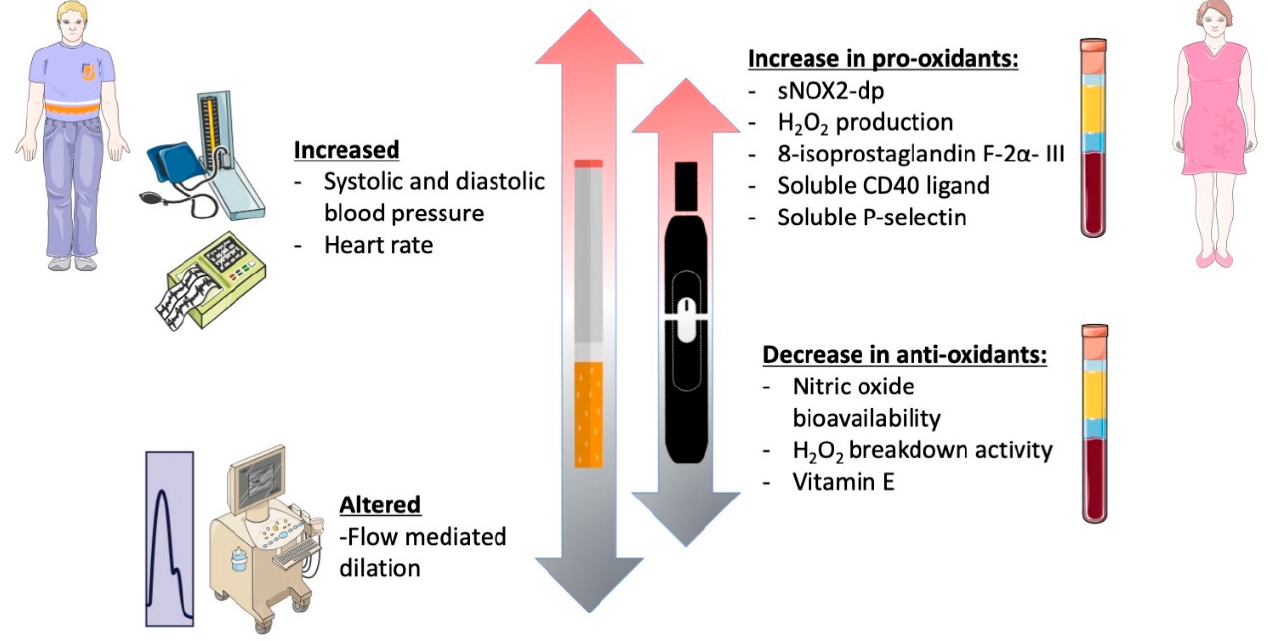
Figure 4. Graphical abstract of the study.